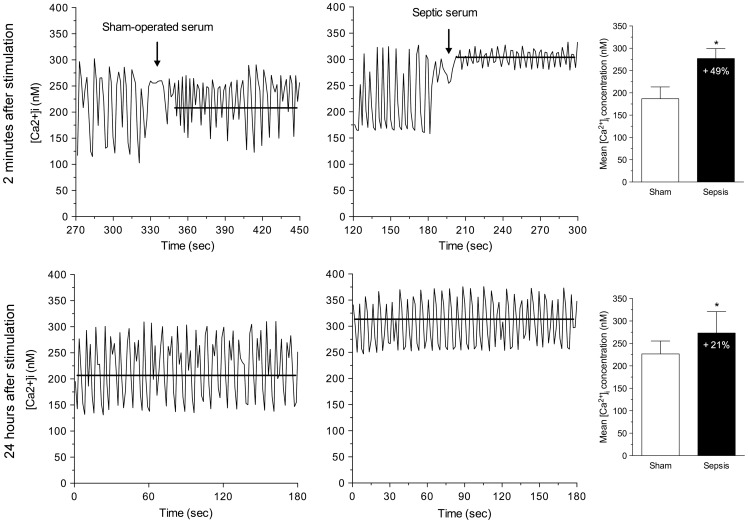
Increment of mean [Ca2+]i after addition of septic serum from mice.Cardiomyocytes exposed to serum from septic mice for 2 minutes (upper panel) presented a marked increment of mean [Ca2+]i, around 49%, due to a rise of diastolic ion levels, with decreased amplitude of the calcium transients as compared to cardiomyocytes incubated with serum from sham-operated mice. Cardiomyocytes exposed to septic serum for 24 hours (bottom panel) demonstrated an effective mean increase of [Ca2+]i, around 21%, due to a rise of both systolic and diastolic ion levels, but the amplitude of systolic and diastolic [Ca2+]i levels were similar in both experimental and control conditions (*, P<0.01).